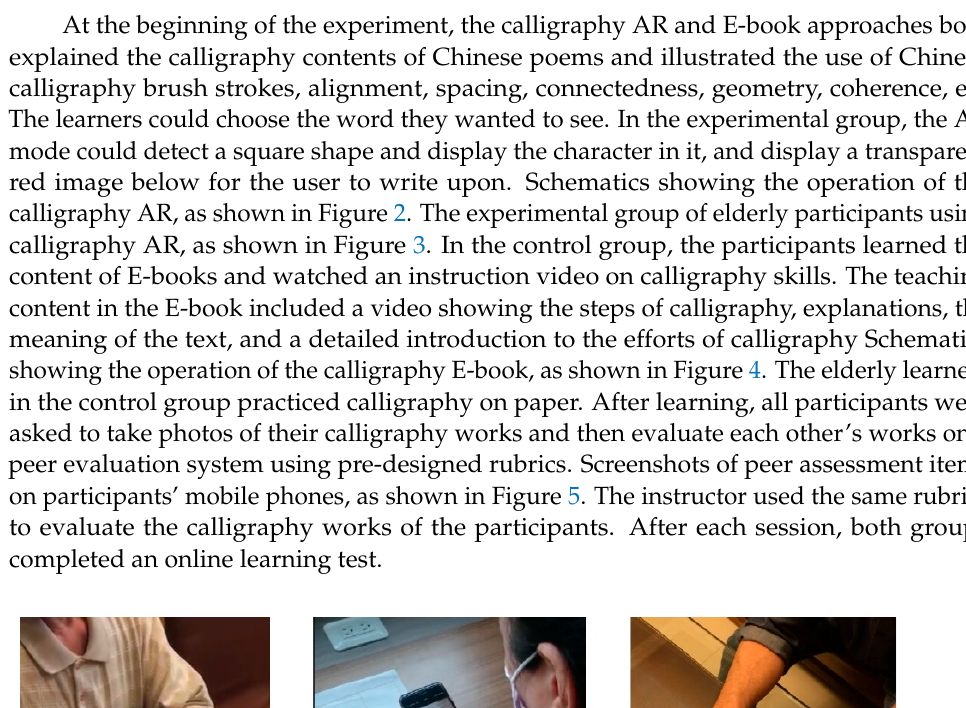
Figure 1. Experimental procedure.